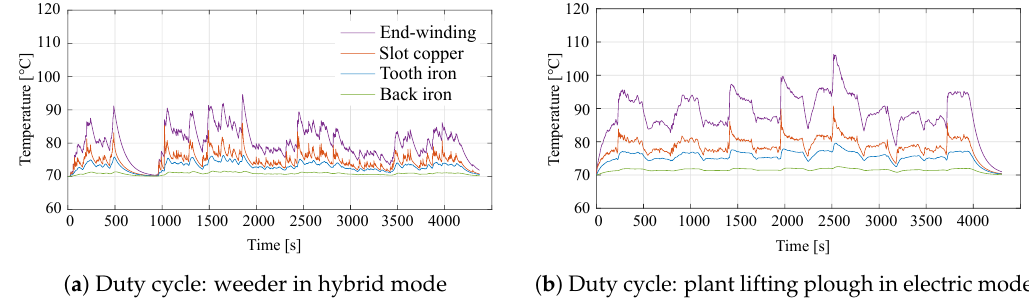
Figure 13. Results of the thermal analysis when the electric motor is subject to a real duty cycle, showing the temperature rise in different parts of the electric motor.